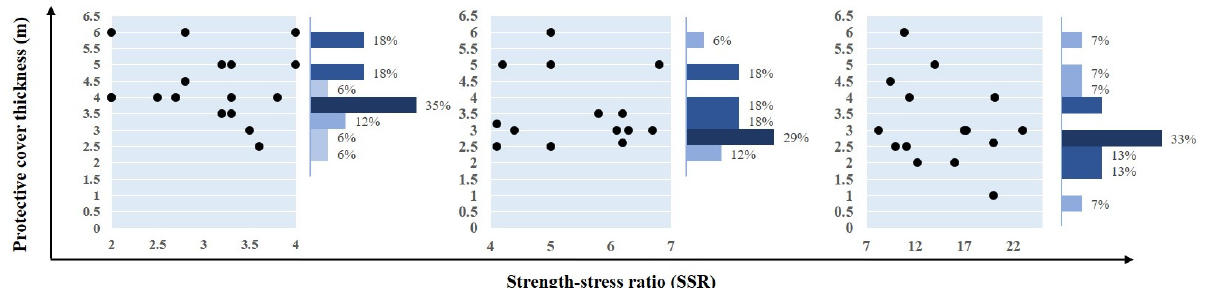
Figure 22. The dominant distribution of protective cover thickness under different SSR at the rock anchor beam zone.